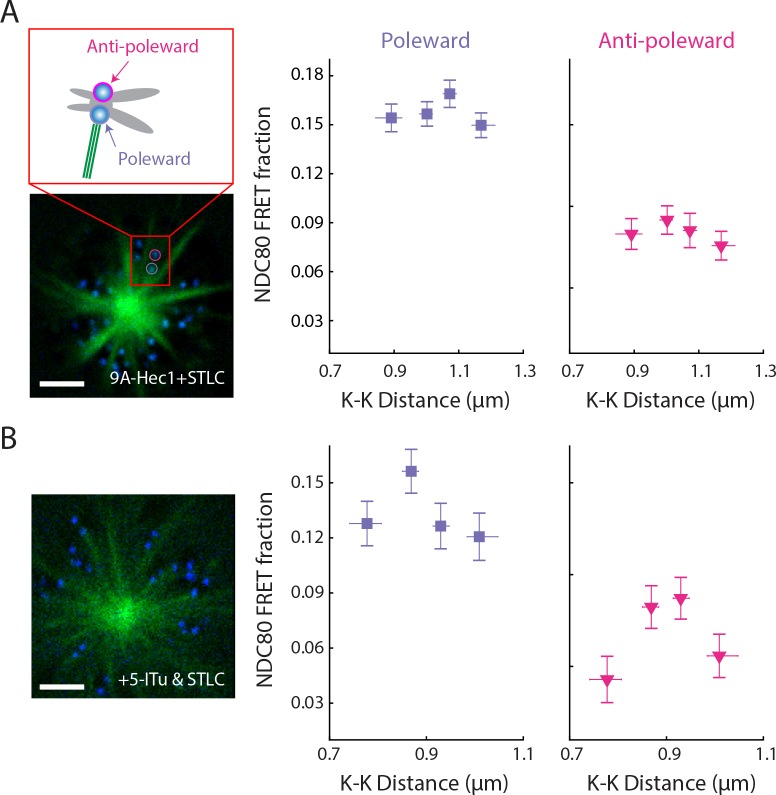
NDC80 FRET fraction of poleward and anti-poleward kinetochores in STLC-induced monopolar spindles of 9A-Hec1-expressing cells and haspin inhibited cells.NDC80 FRET fraction vs. K-K distance for poleward-facing kinetochores (purple squares, same as Figure 5) and anti-poleward-facing kinetochores (pink triangles) in (A) 9A-Hec1-expressing cells treated with 5 μM STLC (n = 10 cells, 855 kinetochores/data point) and (B) endogenous-Hec1-expressing cells treated both with 10 μM 5-ITu and 5 μM STLC (n = 12 cells, 564 kinetochores/data point). Data points are the mean, y-error bars the SEM, and the x-error bars the interquartile ranges within groups of kinetochores with similar K-K distances. 3 µm scale bar.